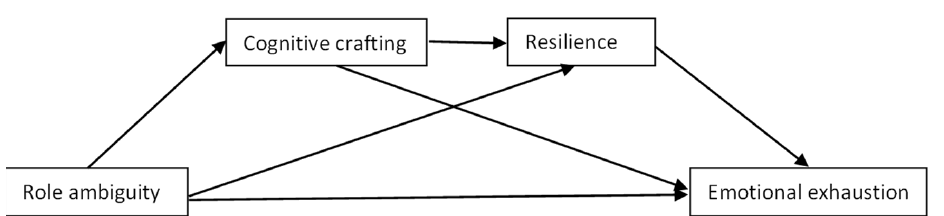
Figure 1. Hypothetical chain mediation model 1 (serial mediators: cognitive crafting and resilience).